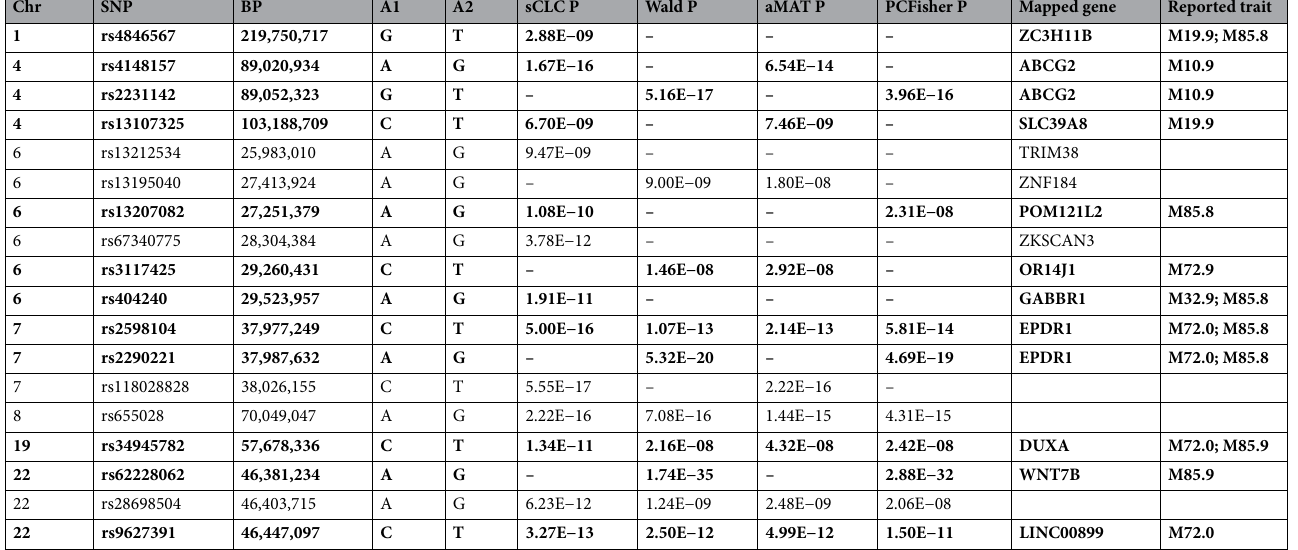
Table 2. Summary statistics of the independent lead SNPs identified by sCLC, Wald, aMAT, PCFisher. The bold out rows indicate that the SNPs/mapped genes have been reported in the GWAS Catalog. “–” represents that the SNP is not an independent lead SNP for the corresponding